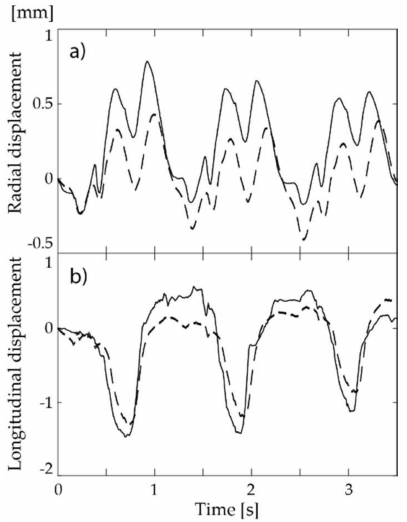
Figure 8. The estimated ( a ) radial and ( b ) lateral position of a kernel in vivo on the intima–media complex of the vessel wall of the common carotid artery in a healthy 47-year-old female obtained using ultrafast ultrasound imaging (solid line) and conventional ultrasound imaging (dashed line). The ultrafast ultrasound imaging was sampled at 1500 Hz and the proposed iterative tracking scheme had an initial length of iteration of k = 64 frames. The conventional ultrasound imaging was sampled at 99 Hz and the tracking was frame-by-frame. The main features of the in vivo curve estimated using a high frame rate cine loop agree well with our low frame rate in vivo measurements. No ECG signal was available for synchronizing the lines and the cine loops were collected 5 minutes apart.